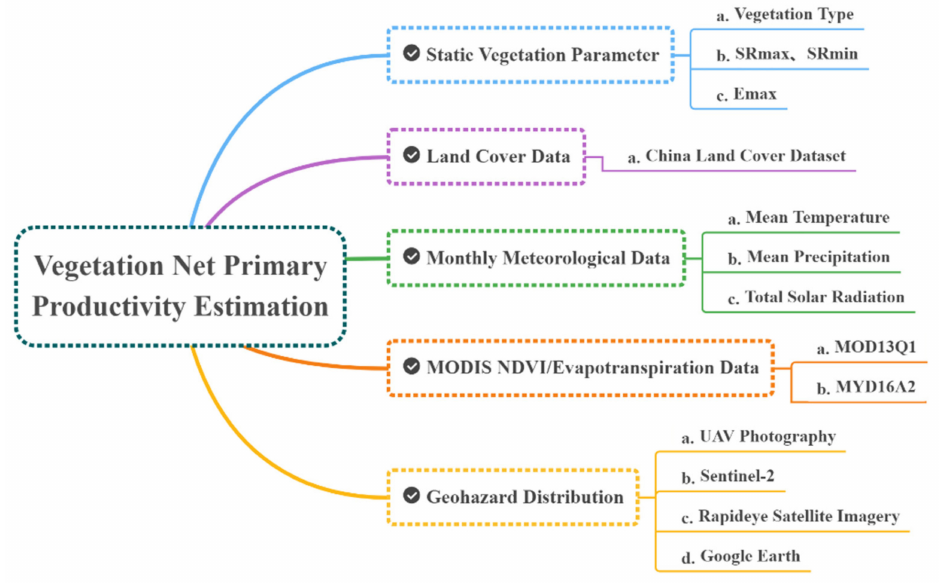
Figure 4. The data components, attributes and sources of NPP